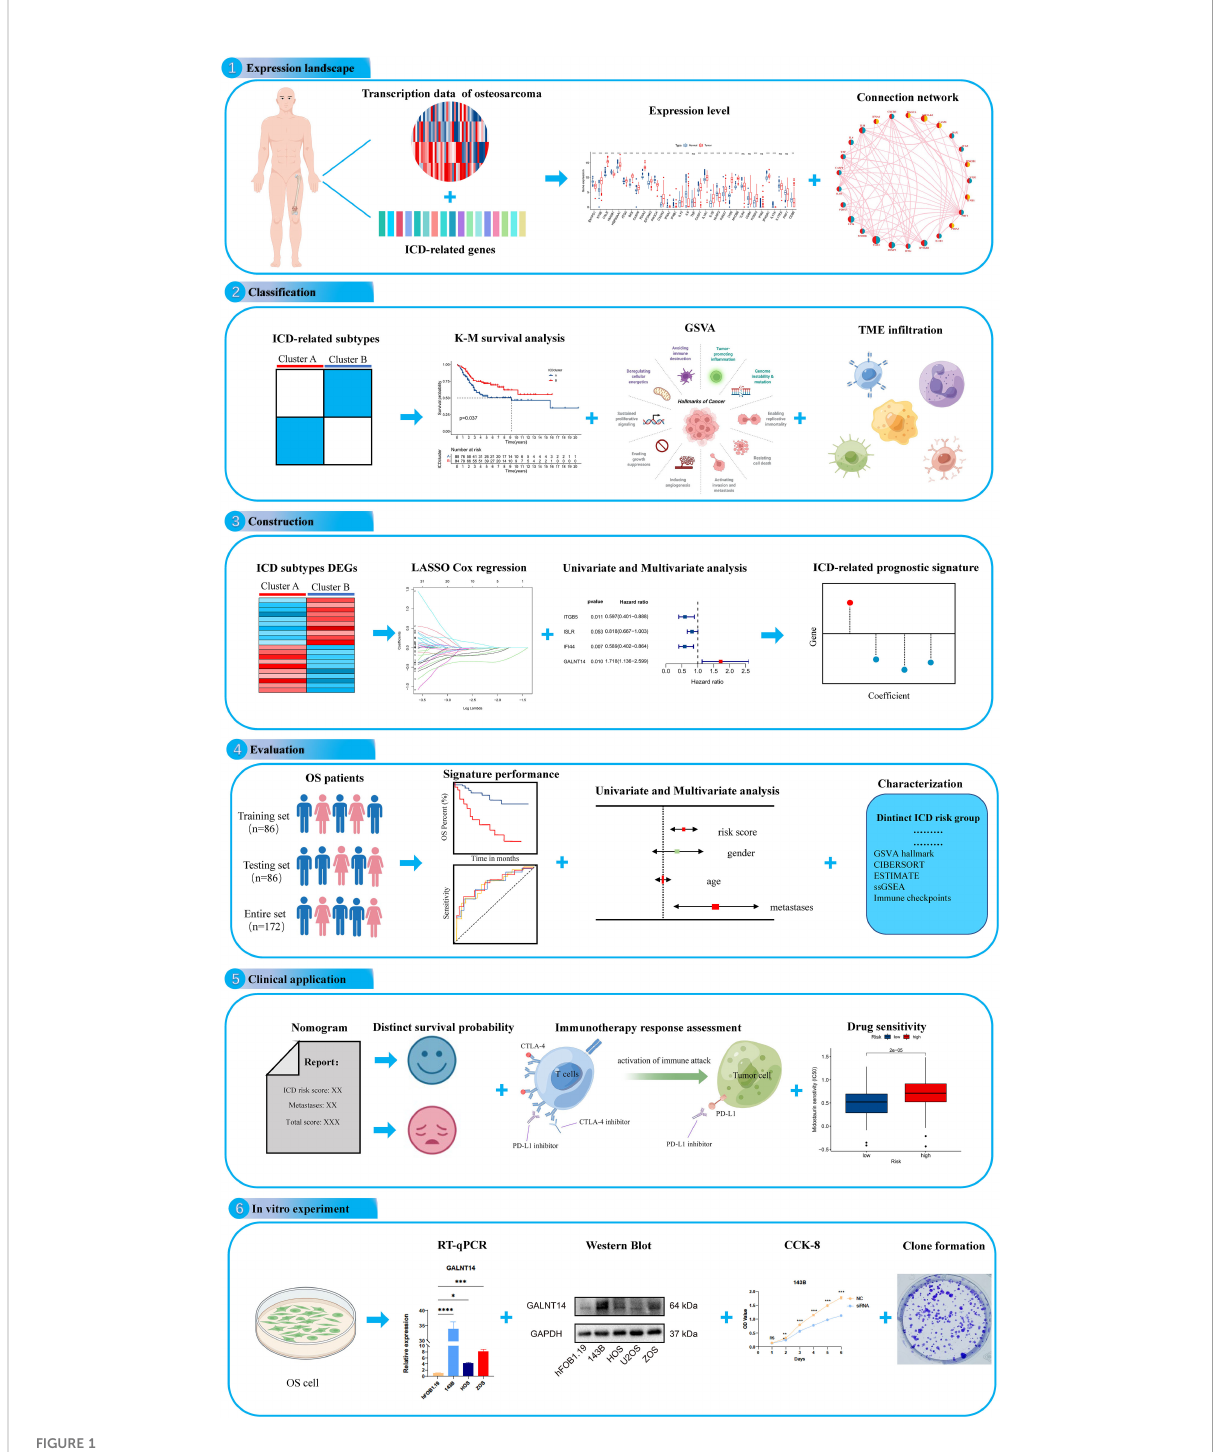
FIGURE 1 The fl ow diagram of the present study. ns, no signi fi cance, *p < 0.05, **p < 0.01, ***p < 0.001,****p <